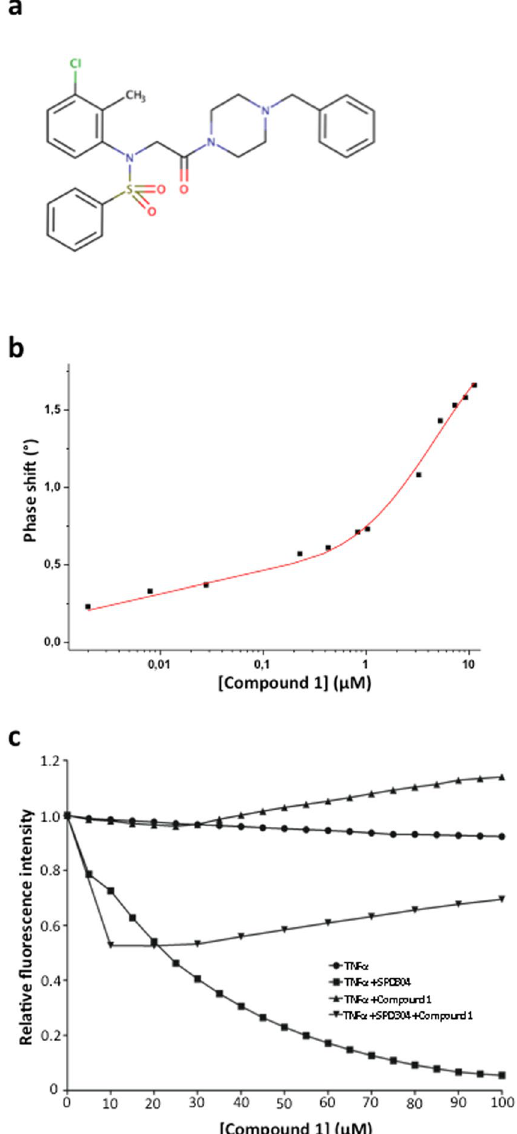
Figure 2. ( a ) Structure of compound 1. ( b ) Dissociation constants of TNF α /Compound 1. Determination of dissociation constants of TNF α /compound 1 complex, from gravimetric biosensor response, by using a “two-site binding” model. K d1 = 4.79 ± 1.12 µ M and K d2 = 2.31 ± 1.03 nM. ( c ) Intrinsic Tryptophane Fluorescence. Intrinsic Tryptophan Fluorescence of 0.5 μ M TNF α diluted in Phosphate Buffered Saline in the presence of DMSO alone, SPD304 (5–100 µ M) in DMSO, compound 1 (5–100 µ M) in DMSO or SPD304 (25 µ M) + compound 1 (10–100 µ M) in